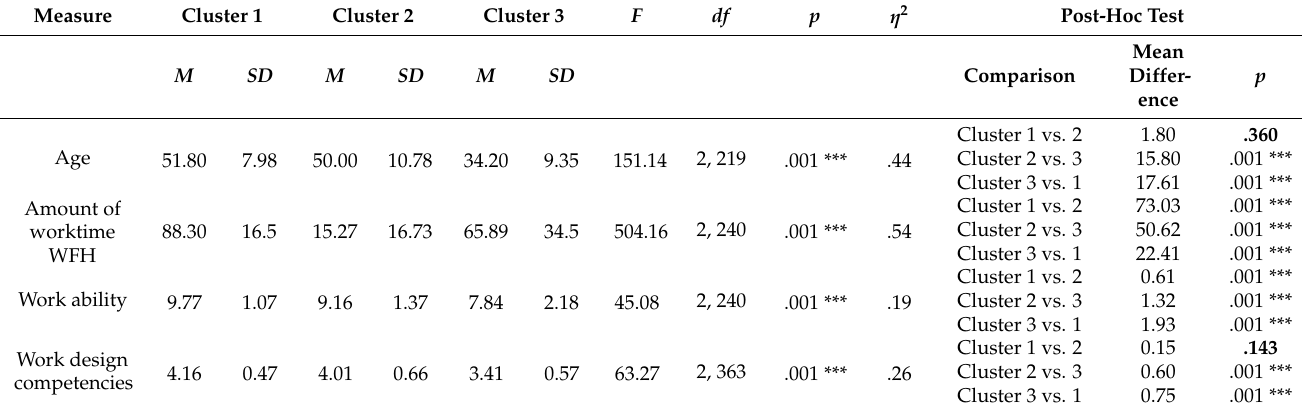
Table 3. Descriptive statistics of the test variables divided into clusters ( N = 366), analyses of variance, and post-hoc